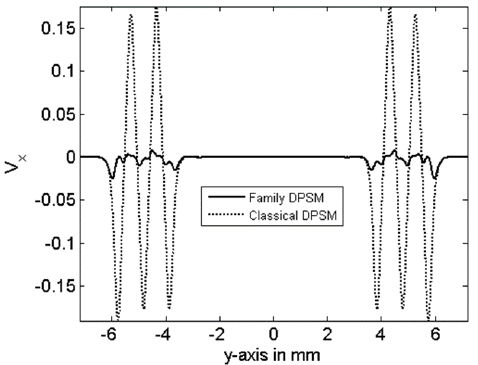
Figure 7. The X-component of the velocity variation on the transducer surface: solid line—computed results using source clusters, as shown in Figure 3; and dashed line—computed by superimposing individual point source contributions, as shown in Figure 1.